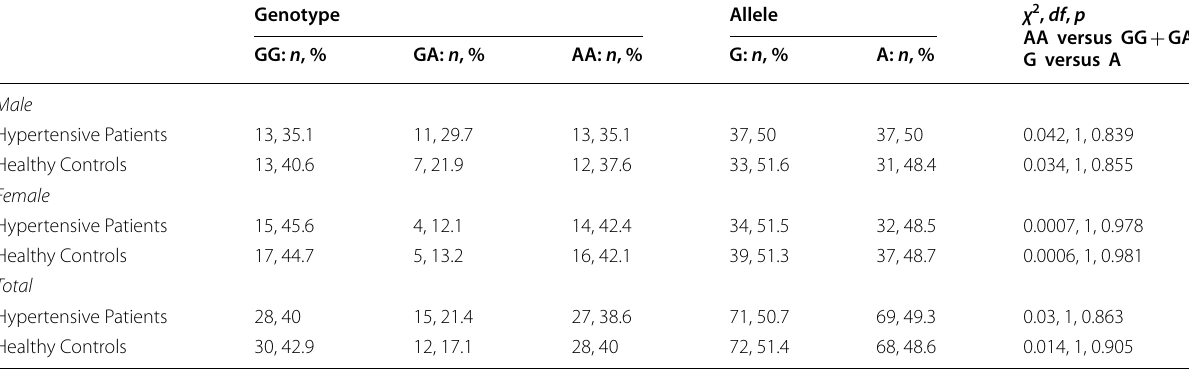
Table 3 Genotype and allele frequencies for the FVL G1691A (rs6025) polymorphism among groups